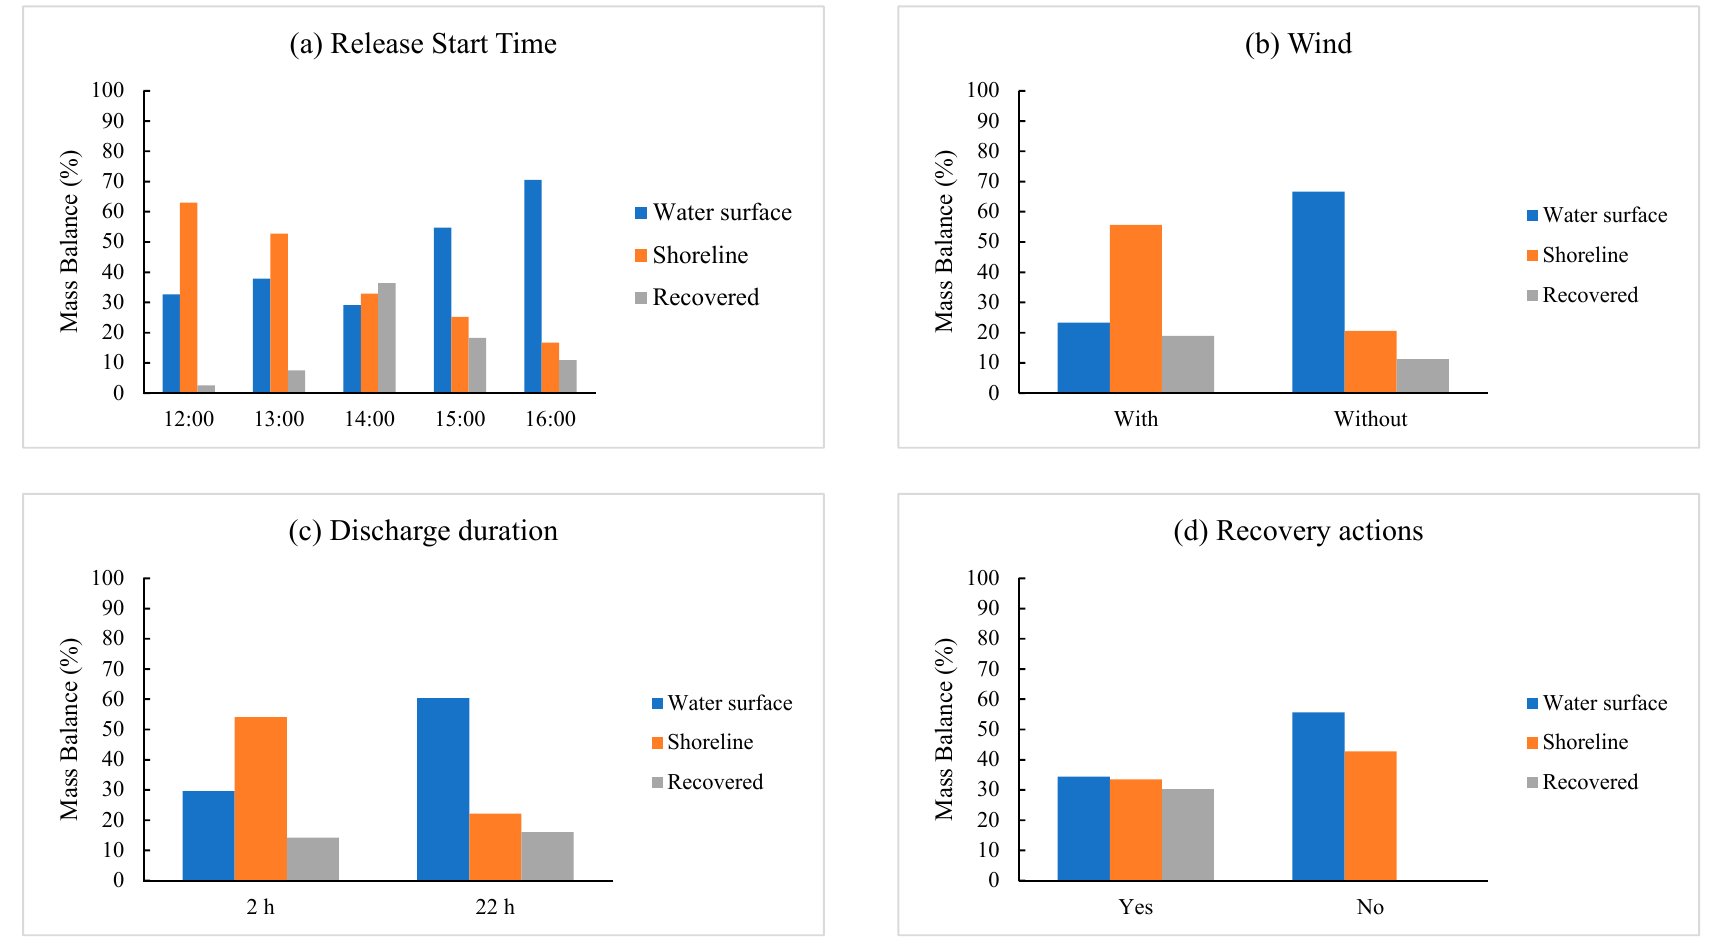
Figure 11. The influence of studied factors ( a ) release start time, ( b ) wind, ( c ) discharge duration and ( d ) recovery action on the mass balance of water surface, shoreline and recovered.